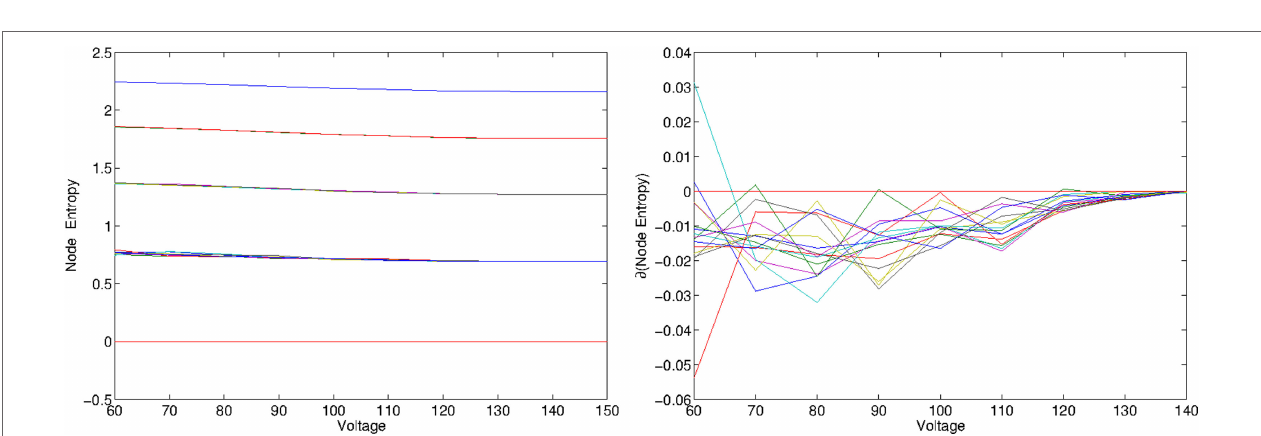
FIGURE 9 | Left: evolution of the resistances and the entropy for various values of the decay parameter (cid:11) and for input V =50V . Left column: case with (cid:11) = 0. We see that the resistances take different final values, but that the entropy converges to some specific values. Central column: case with (cid:11) = 0.5. For this intermediate value of (cid:11) , we observe that some memristances decay to the R off value, meanwhile some resistances flow to the R on state. In this case, we observe that the entropy can take different values. Right column: for (cid:11) = 100, all resistances quickly converge to the R off value. However, we observe an analogous entropy configuration to the one of the case (cid:11) = 0.